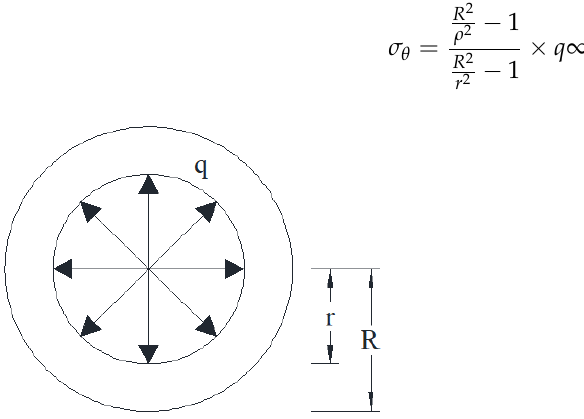
Figure 1. Internal pressure distribution of the circular pore in a plate [16].